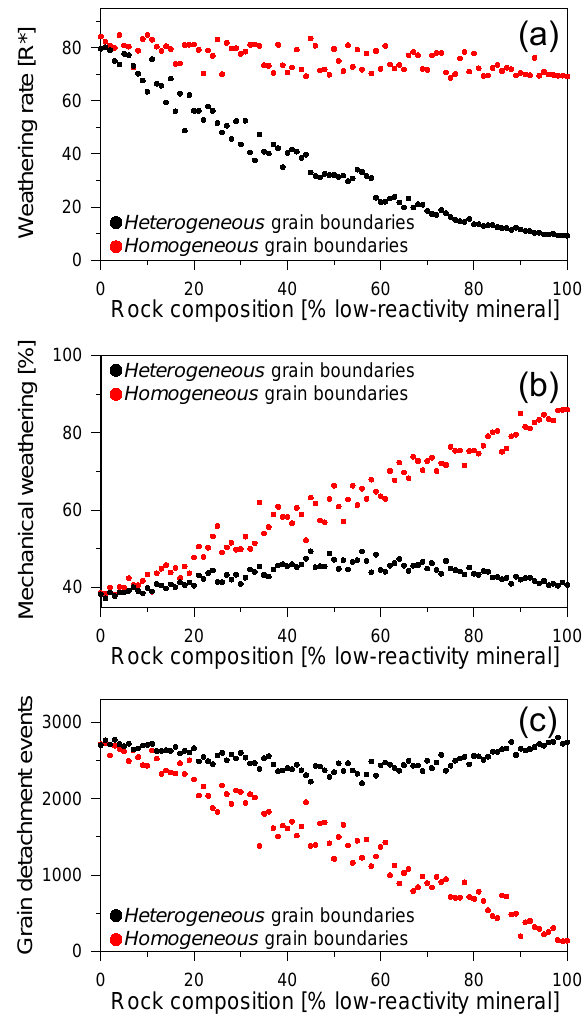
Figure 7. Impact of rock composition on weathering in heteroge- neous and homogeneous grain boundary models. (a) Weathering rate in R ∗ units versus composition; (b) ratio of mechanical weath- ering to total weathering as a function of composition; and (c) the number of detachment events versus composition. The heteroge- neous model assumes that the reactivity for each grain boundary is dependent on the type of the adjacent minerals, while in the homo- geneous model all boundaries have the same